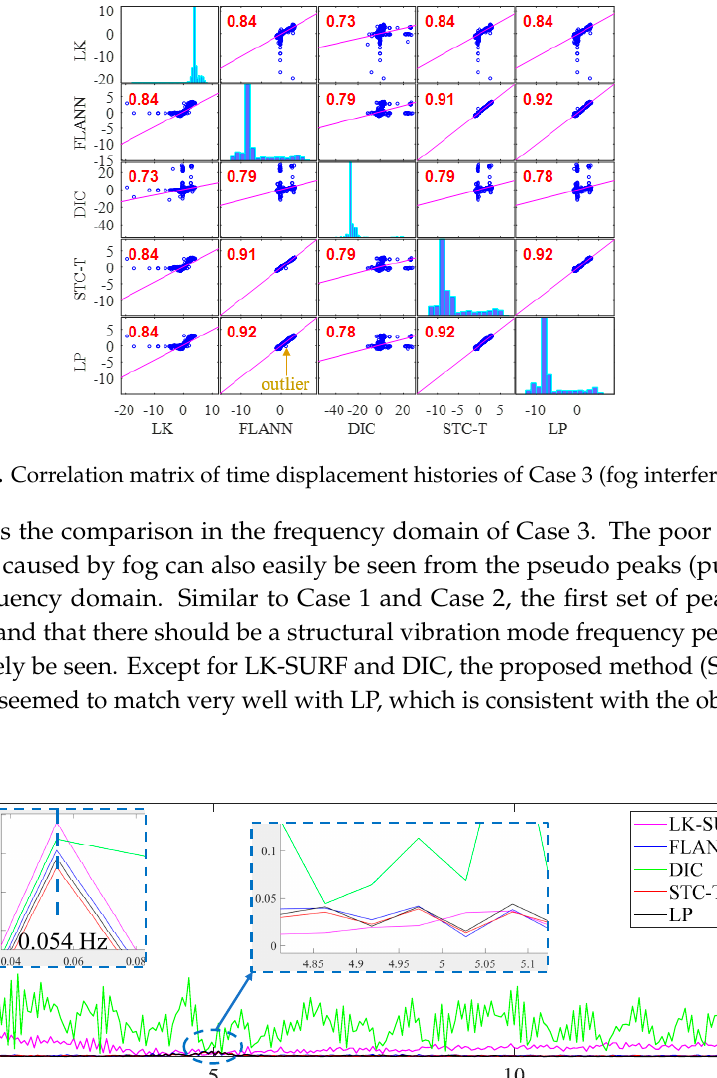
Figure 20. Zoomed in section of the horizontal displacement time histories of P1.